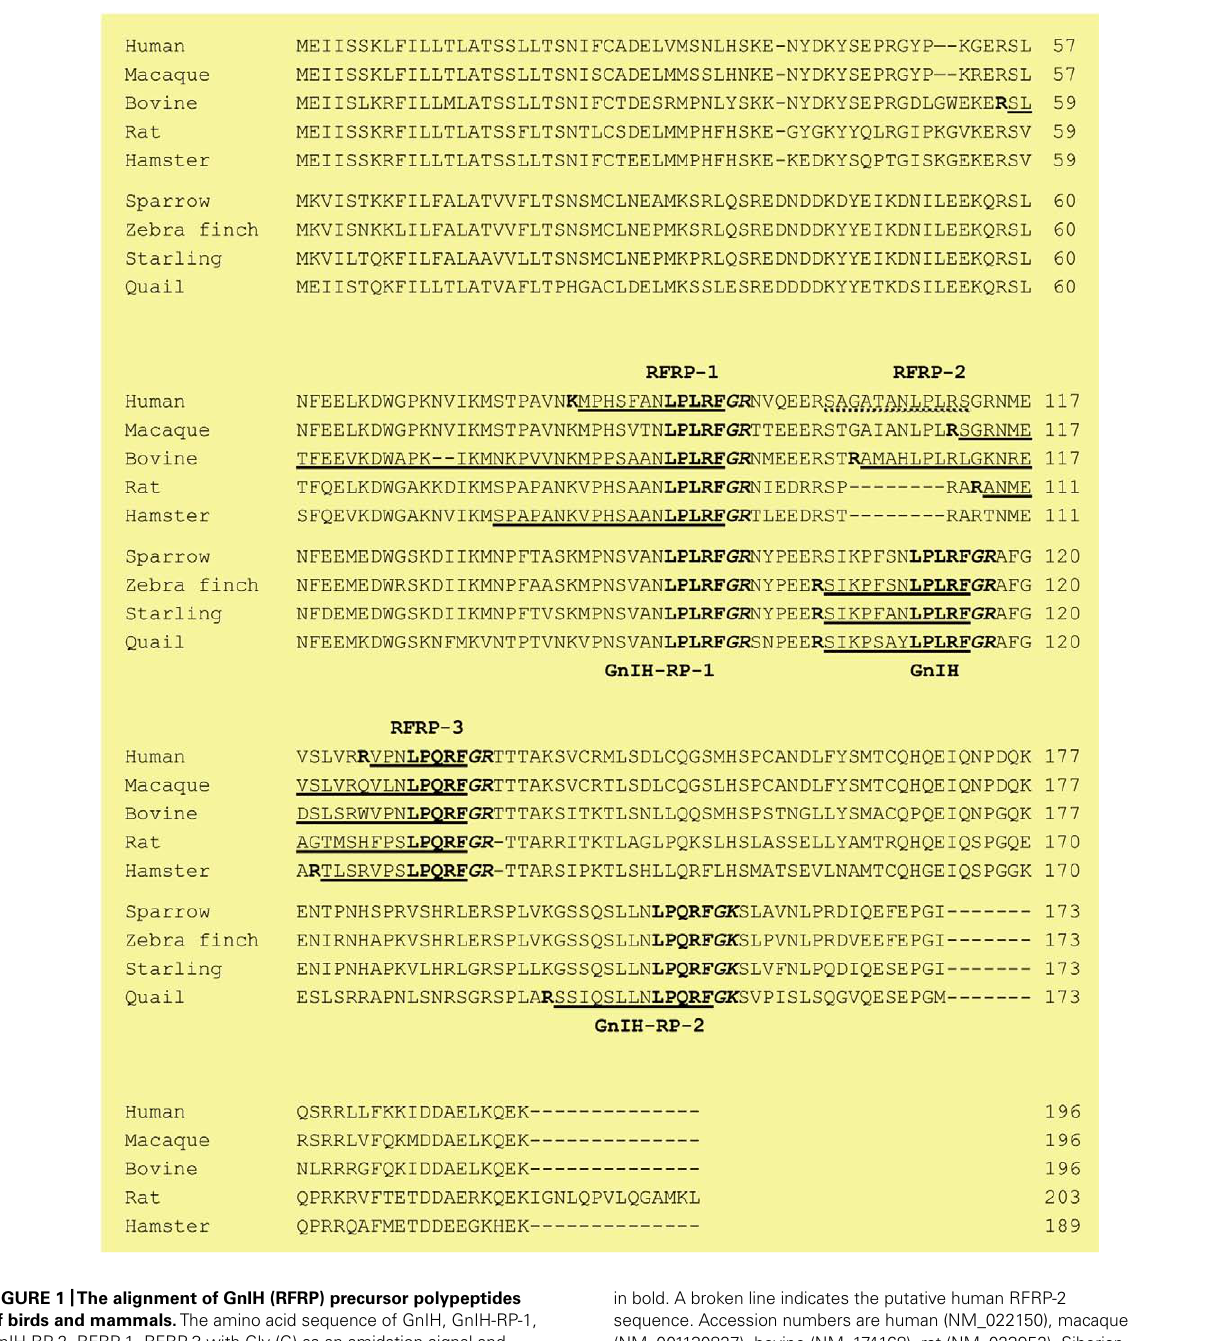
FIGURE 1 |The alignment of GnIH (RFRP) precursor polypeptides of birds and mammals. The amino acid sequence of GnIH, GnIH-RP-1, GnIH-RP-2, RFRP-1, RFRP-3 with Gly (G) as an amidation signal and Arg (R) or Lys (K) as an endoproteolytic basic amino acid at the C- termini are shown in bold. Identified mature peptides are underlined. Endoproteolytic basic amino acid (R or K) at the N-termini are also shown